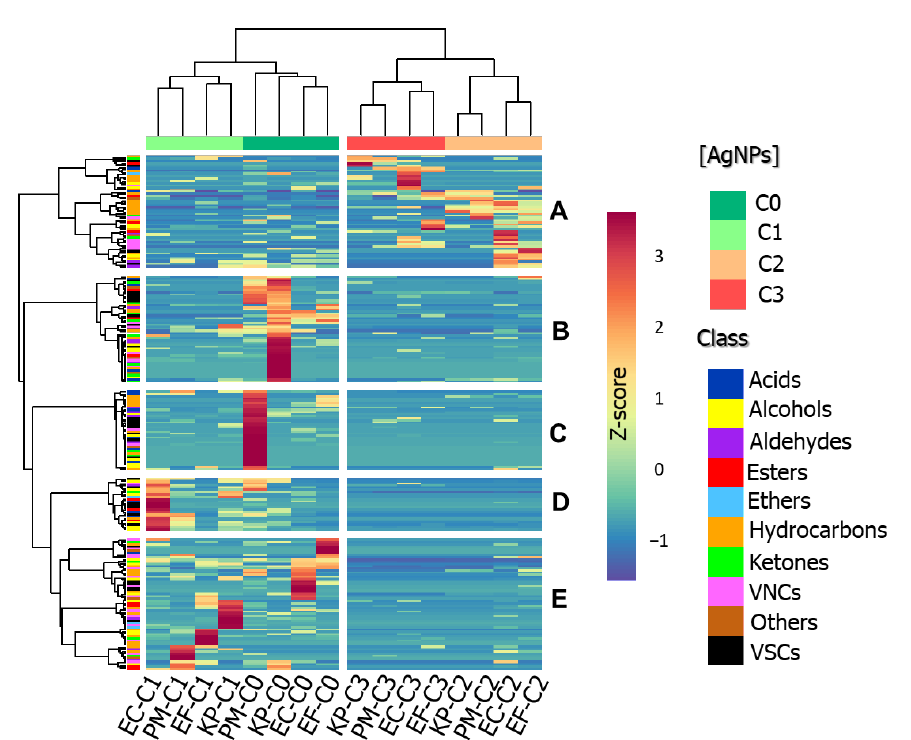
Figure 3. HCA associated with heatmap, displaying changes in VOCs’ intensities in studied volatile bacterial profiles and showing the assigned clusters (Pearson method). EC = E. coli , EF = E. faecalis , KP = K. pneumoniae , PM = P. mirabilis .